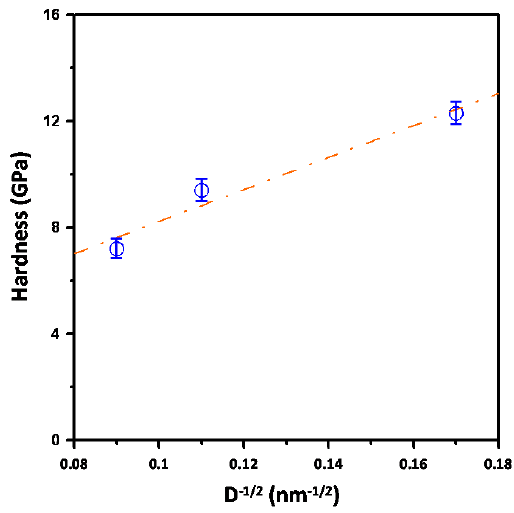
Figure 4. Plot of the experimental data of hardness versus the grain size. The dashed line is a fit to the data using the Hall-Petch equation with the form of 2/1 46.6439.1)(   DDH